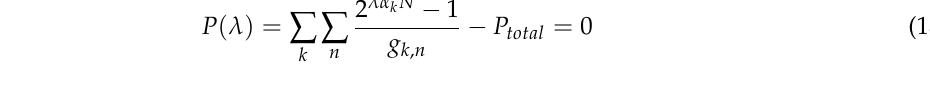
Algorithm 1 BOPA